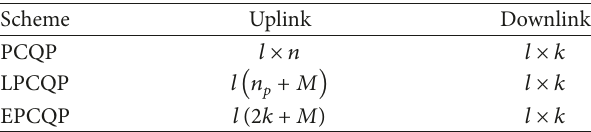
Table 2: Comparison of communication cost. Scheme Uplink Downlink PCQP 𝑙 × 𝑛 𝑙 × 𝑘 LPCQP 𝑙 (𝑛 𝑝 + 𝑀) 𝑙 × 𝑘 EPCQP 𝑙(2𝑘 + 𝑀) 𝑙 × 𝑘 n and 𝑛 𝑝 denote the number of all entries in the POI-table and a subtable,